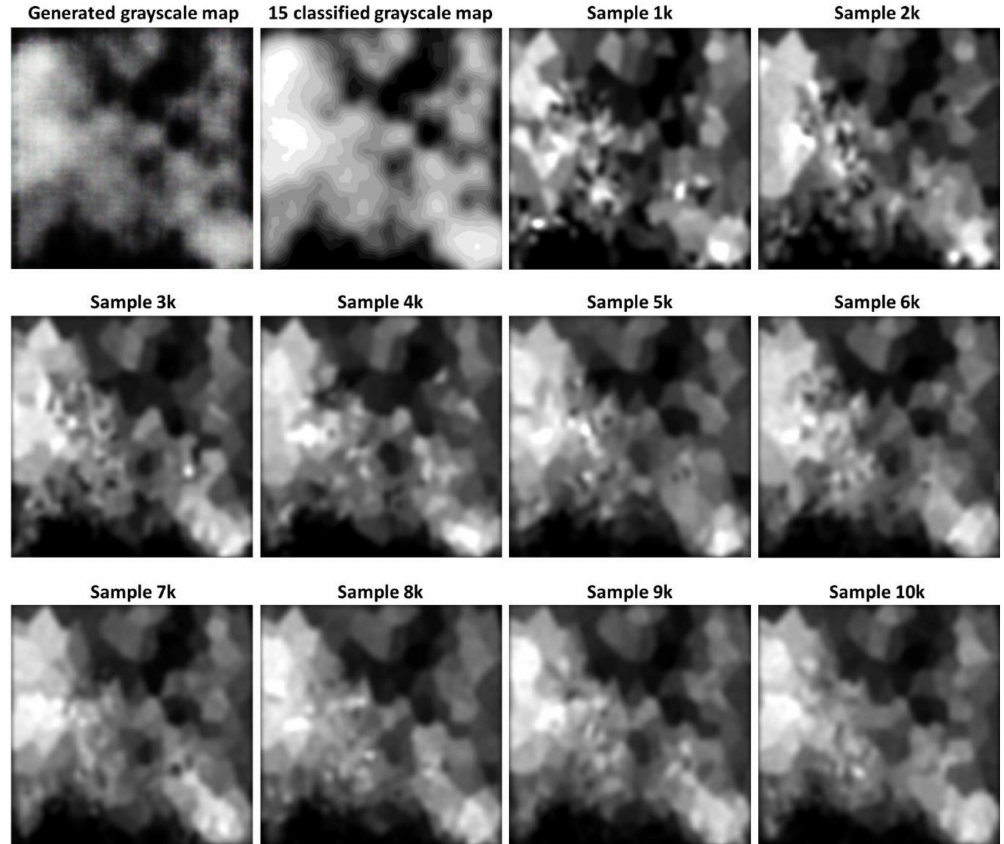
Figure 10. Kernel density map of the estimated people density distribution for one example test, using di ff erent rendering results according to di ff erent sampling number points. The first one is the baseline artificial map, and the second one is the same distribution, but where the density is classified into 15 classes, to show the di ff erence between images and raster grids map rendered by kernel density estimation (KDE). The other 10 images are the estimated results using our method when we sample di ff erent points as mobile phone users from 1000 to 10,000.